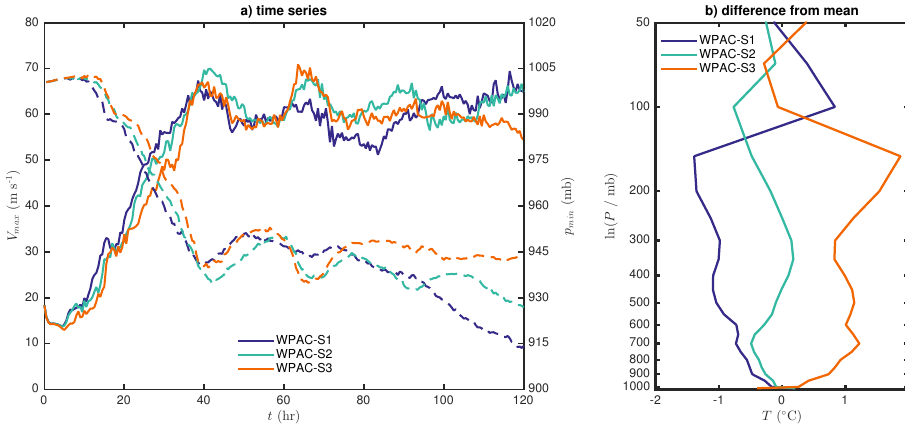
Figure 8. As in Figure 4 but for the WPAC subdomain 1 (blue lines), subdomain 2 (green lines), and subdomain 3 (orange lines)